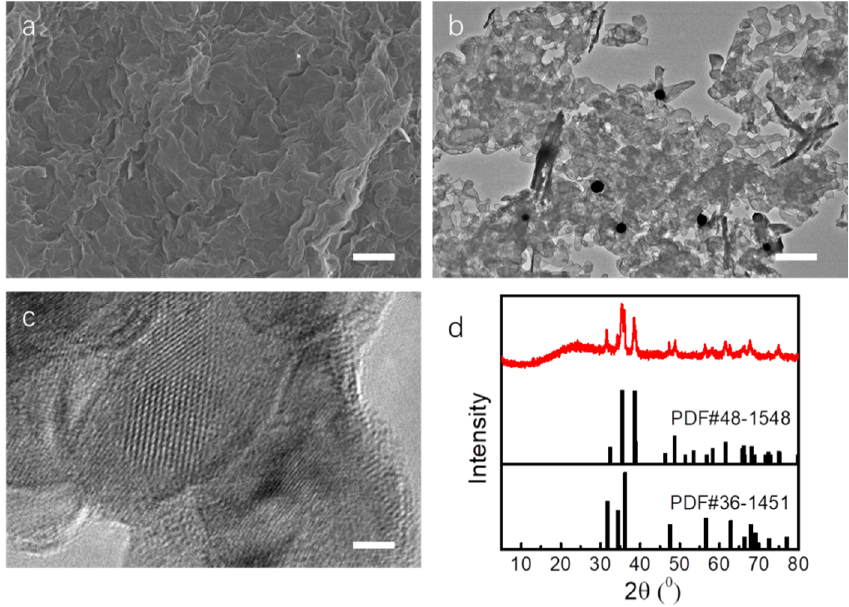
Figure 1. Scanning electron microscope (SEM) images ( a ), transmission electron microscope (TEM) images ( b ), high-resolution TEM (HRTEM) image ( c ) and X-ray diffraction (XRD) patterns of catalysts ( d ). Scale bars: 400 nm in ( a ), 800 nm in ( b ), 1 nm in ( c ).